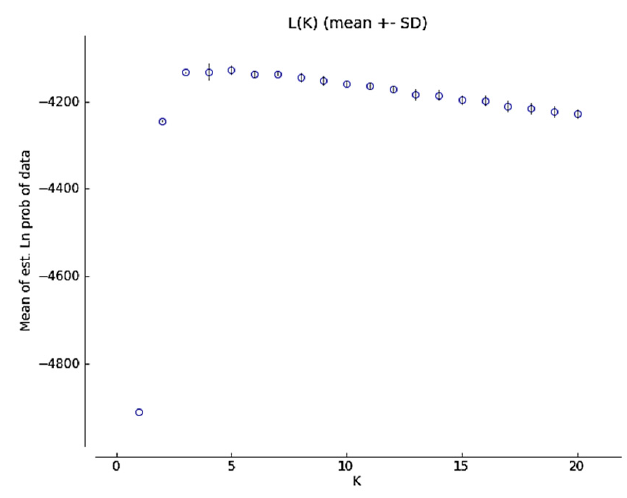
Figure A3. Delta K plot for the Southern Zone.